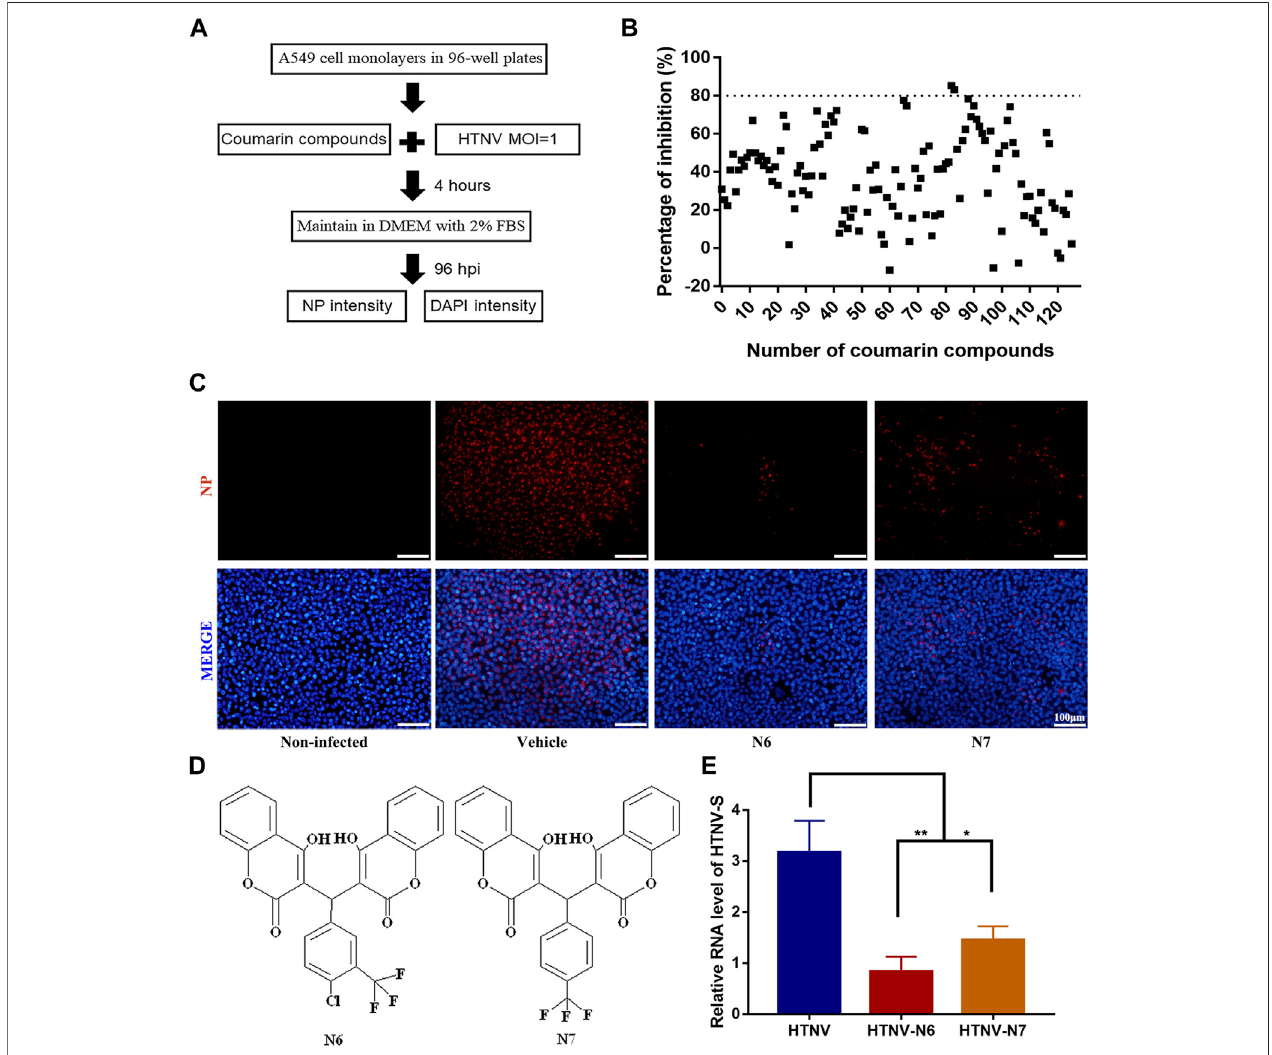
FIGURE 1 | In vitro anti-HTNV activity of coumarin derivatives N6 and N7 (A) Preliminary screening of coumarin derivatives with anti-HTNV activity (B) Two compounds (N6 and N7) of the126 coumarin derivatives showed a signi fi cant inhibitory activity against HTNV by a HTS assay (C) Validation of the anti-HTNV activity of N6 and N7 by immuno fl uorescence assay, scale bar (cid:2) 100 μ m (D) The chemical structure of N6 and N7 (E) The expression of HTNV-S RNA in HTNV-infected cells treated by vehicle (control), N6, and N7. Results of the statistical analyses are depicted as follows: Student ’ s t test or one-way ANOVA; * p < 0.05, ** p < 0.01 vs HTNV, n (cid:2)